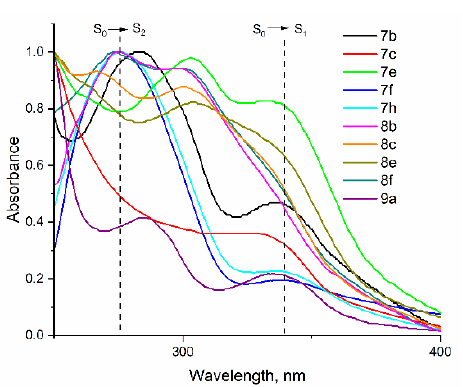
Figure 3. Normalized absorption spectra of pyranoindoles 7b – 8b , 7c – 8c , 7e – 8e , 7f – 8f , 7h , and 9a in MeCN (c = 10 − 5 M).